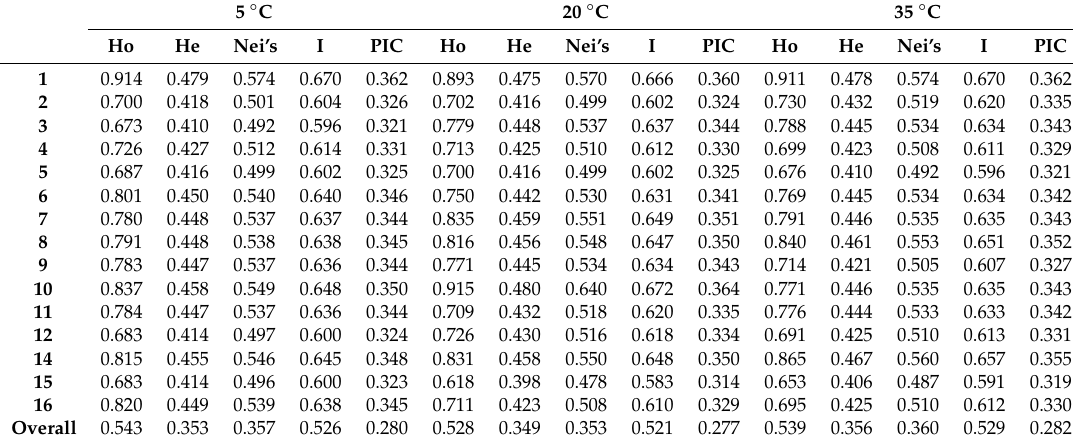
Table 1. Genetic diversity indexes of C. dactylon of di ff erent population at di ff erent